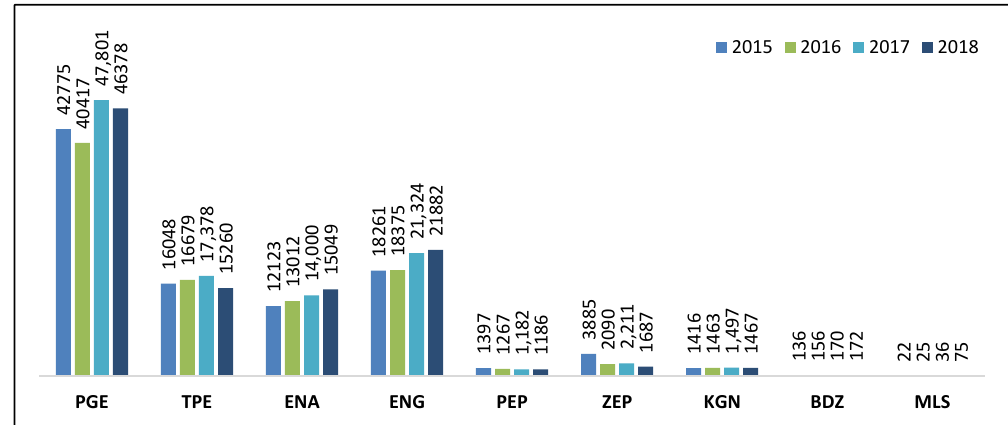
Energies 2020 , 12 , x FOR PEER REVIEW 12 of 21 Figure 3. Sampled companies according to volume of assets (in mln of PLN). Figure 3. Sampled companies according to volume of assets (in mln of PLN).